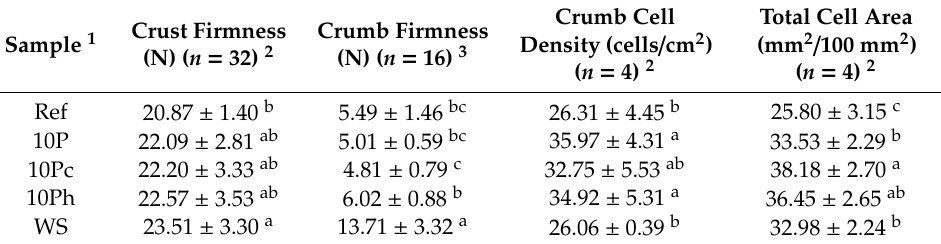
Table 3. Bread texture as a ff ected by wheat flour replacement.